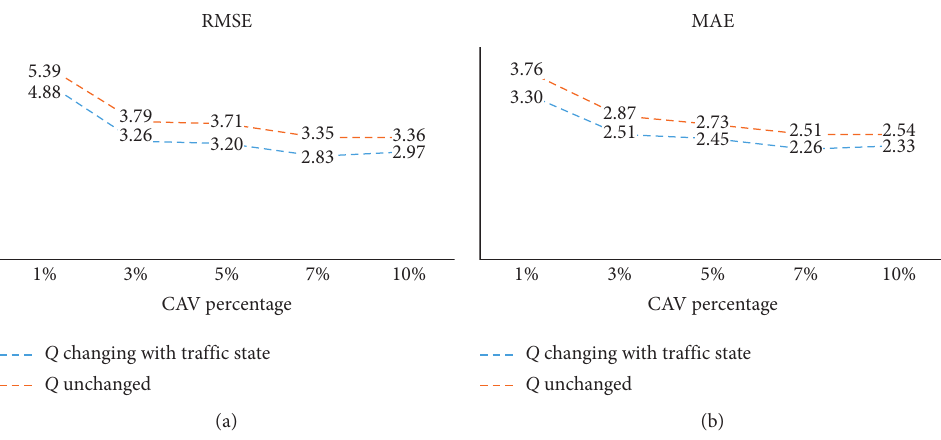
Figure 11: The impact of state error ( Q ) on accuracy. (a) Impact on RMSE. (b) Impact on